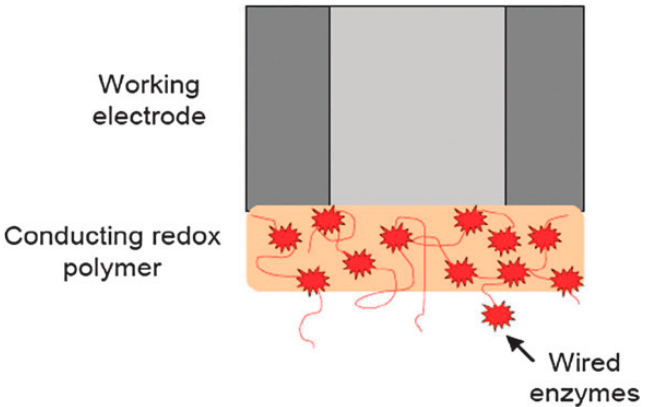
Figure 3. Schematic diagram of third-generation catalytic biosensor [2]. Copyright 2010. Reproduced with permission from The Royal Society of Chemistry.